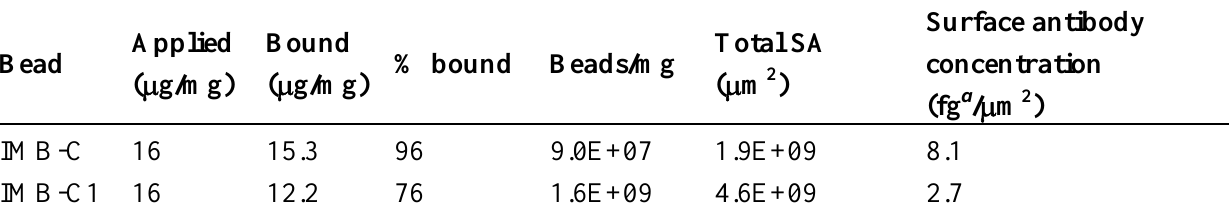
Table 2. Bound antibody